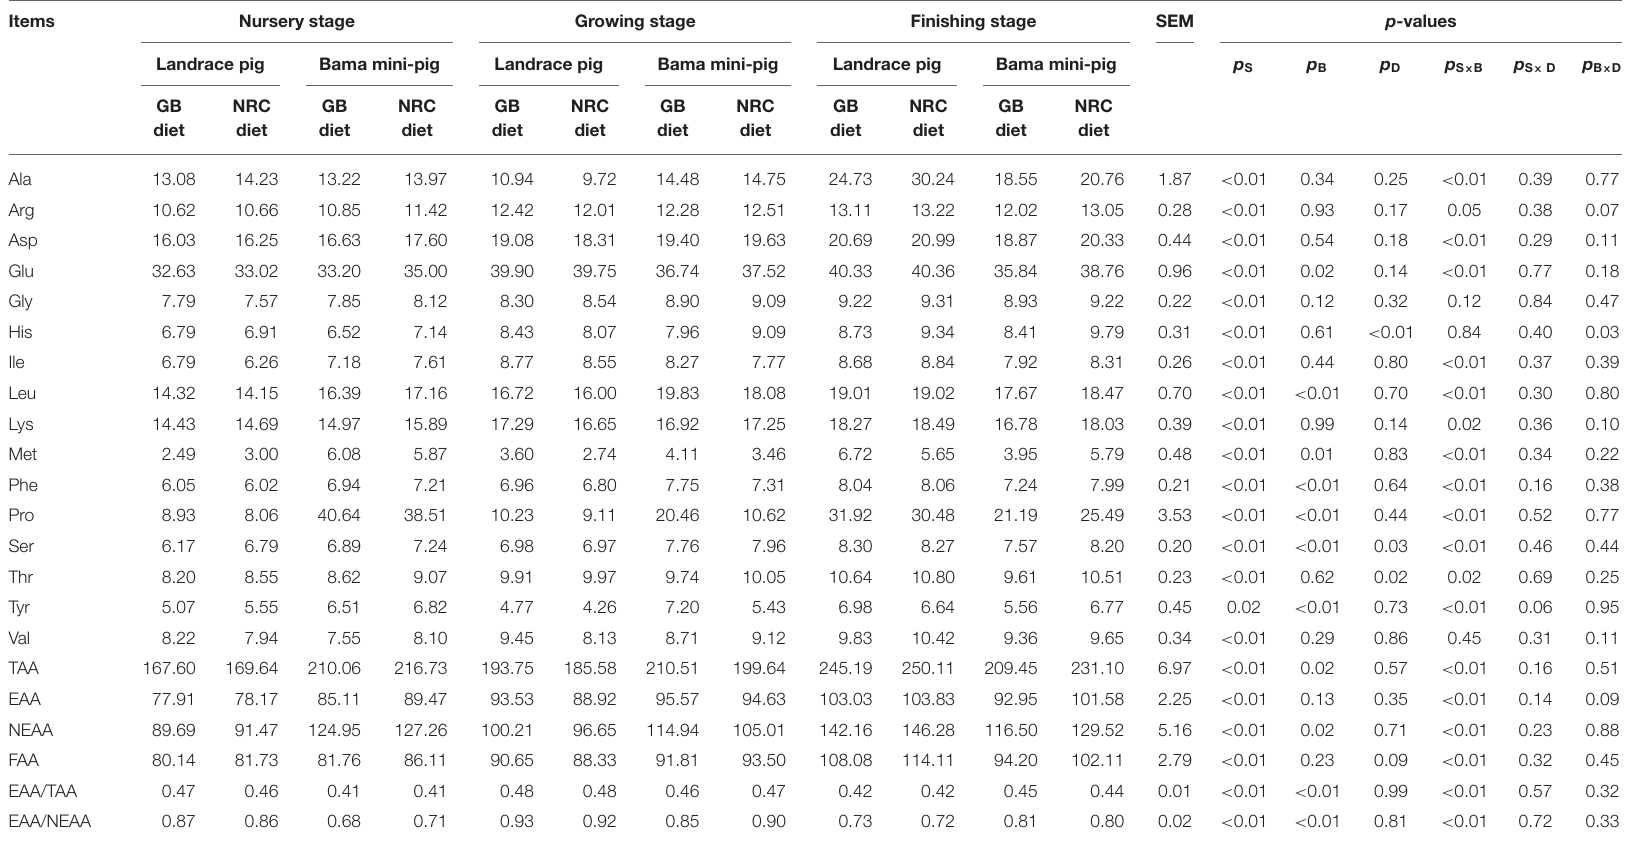
Values are expressed as mg/g fresh muscle tissue (means with pooled SEM), n = 8 per treatment group. S, stage; B, breed; D, diet; S × B, stage × breed interaction; S × D, stage × diet interaction; B × D, breed × diet